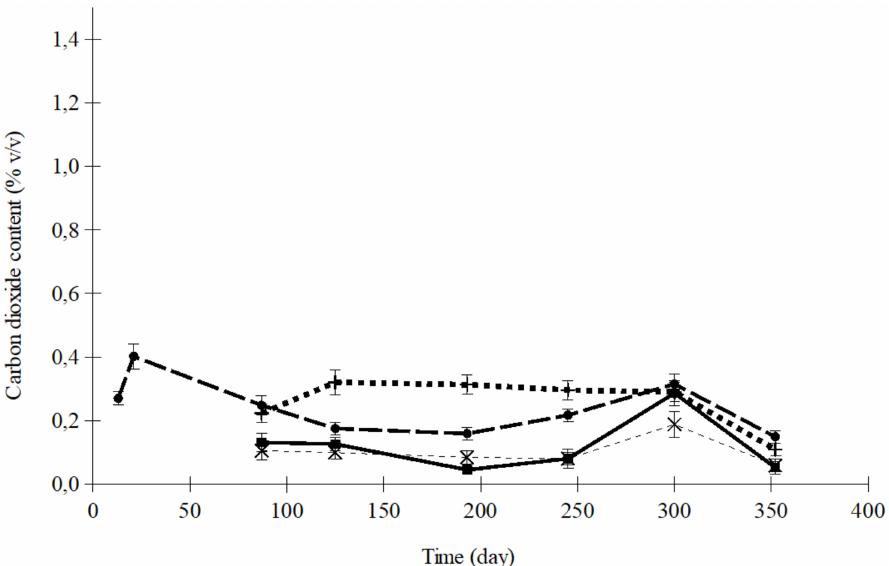
Figure 5. CO 2 concentration in trays containing dried apricots sealed with OPA/PE 15/100 film and flushed with N 2 ( × , 5 ◦ C; (cid:4) , 15 ◦ C; +, 25 ◦ C; • , 35 ◦